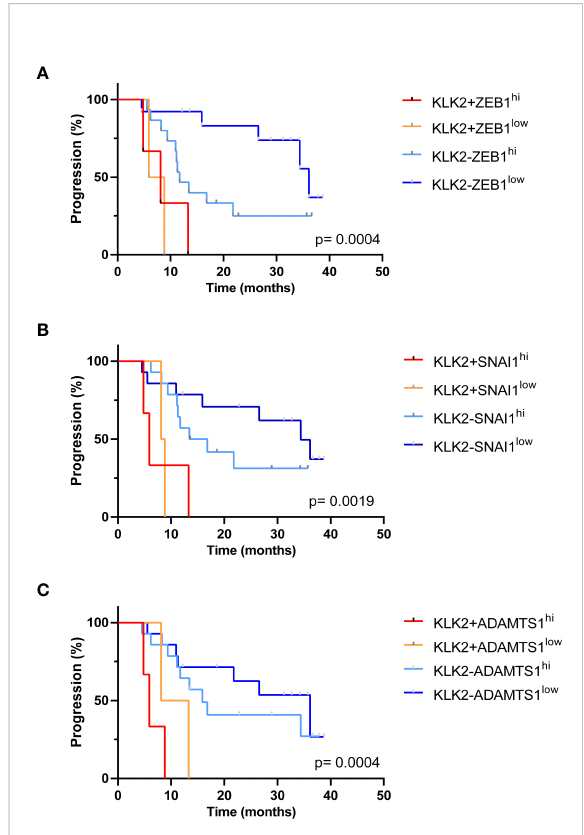
FIGURE 6 Kaplan Meier analysis of patients expressing multiple poor prognostic genes. (A) The median PFS for patients with KLK2 + ZEB1 hi was 8.13 months, which was signi fi cantly shorter than KLK2 - ZEB1 low group (36.13 months) with p= 0.0008. Overall Logrank p= 0.0004. (B) The median PFS for patients with KLK2 + SNAI1 hi was 5.9 months. KLK2 + SNAI1 hi vs. KLK2 - SNAI1 hi : 5.9 vs. 15.15 months, p= 0.019; KLK2 + SNAI1 hi vs. KLK2 - SNAI1 low : 5.9 vs. 34.40 months, p= 0.0083. Logrank p= 0.0019. (C) The median PFS for patients with KLK2 + ADAMTS1 hi was 5.9. KLK2 + ADAMTS1 hi vs. KLK2 + ADAMTS1 low : 5.9 vs. 10.73 months, p= 0.28; KLK2 + ADAMTS1 hi vs. KLK2 - ADAMTS1 hi : 5.9 vs